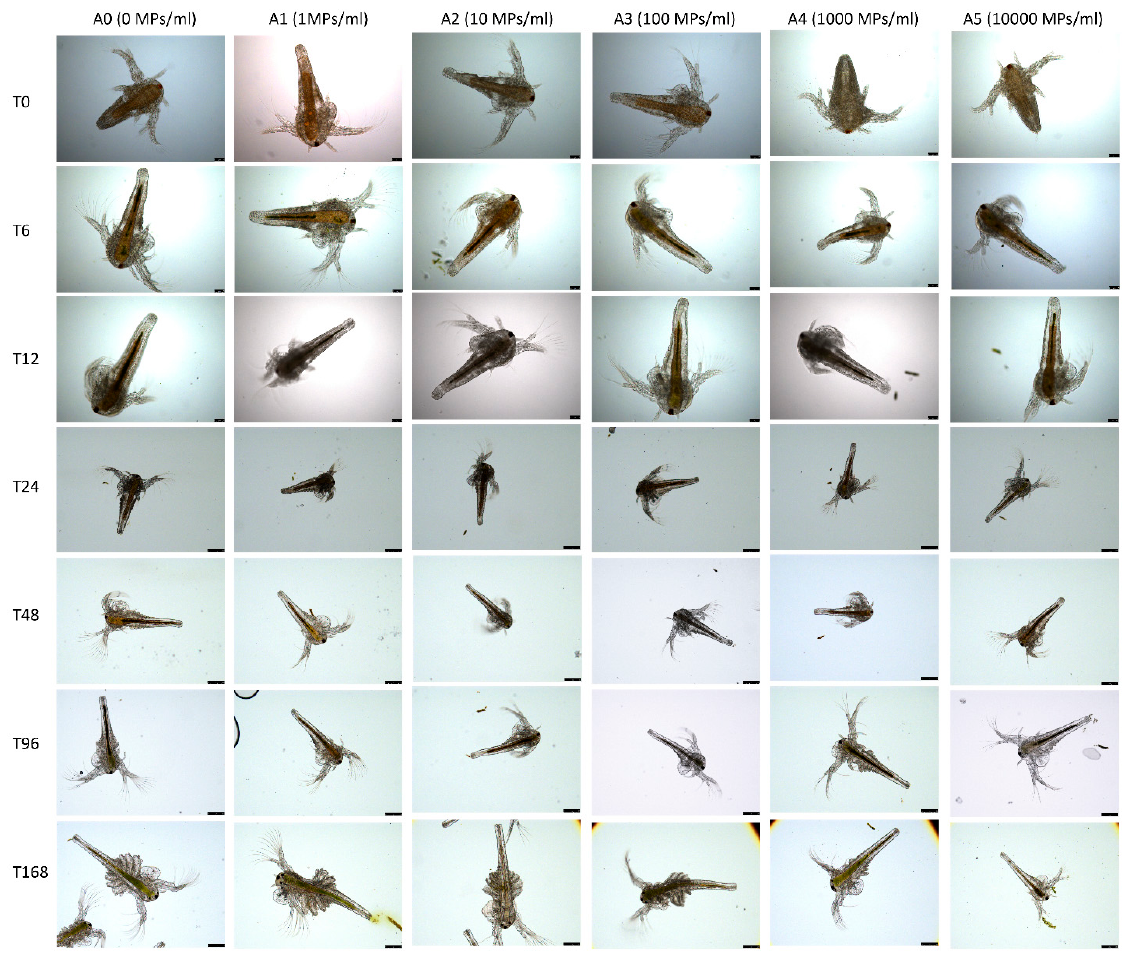
Figure 5. Development of Group A Artemia salina nauplii six treatments (A0–A5) in time (0–168 h). Scale bars: 75 µm for time points T0. 250 µm for time points T24–T168.